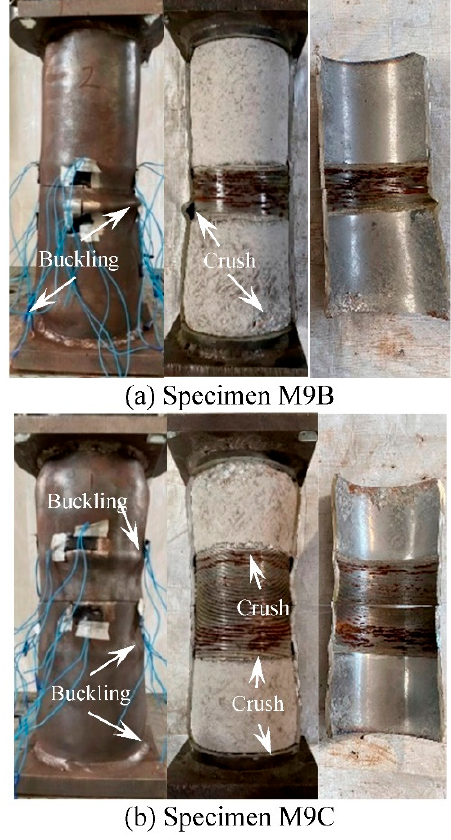
Figure 9. N - Δ curves of specimens without thread.